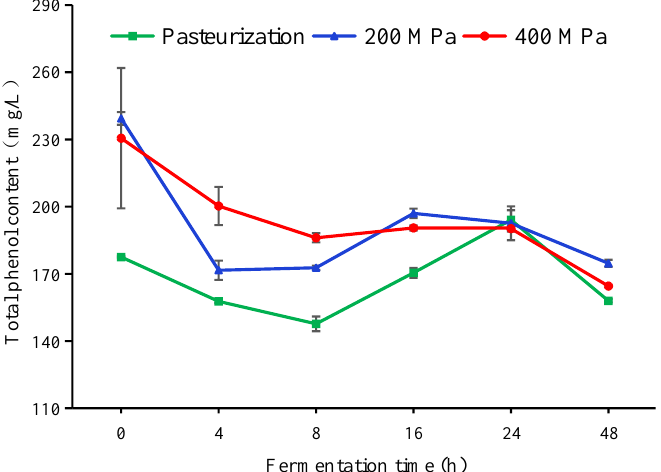
Figure 6. Total phenol content of apple juice with different treatments during fermentation. HHP treatments (200 or 400 MPa, 10 min); pasteurization (85 °C, 15 min). Experiments were performed in triplicate; vertical bars indicate ± SD ( p < 0.05).